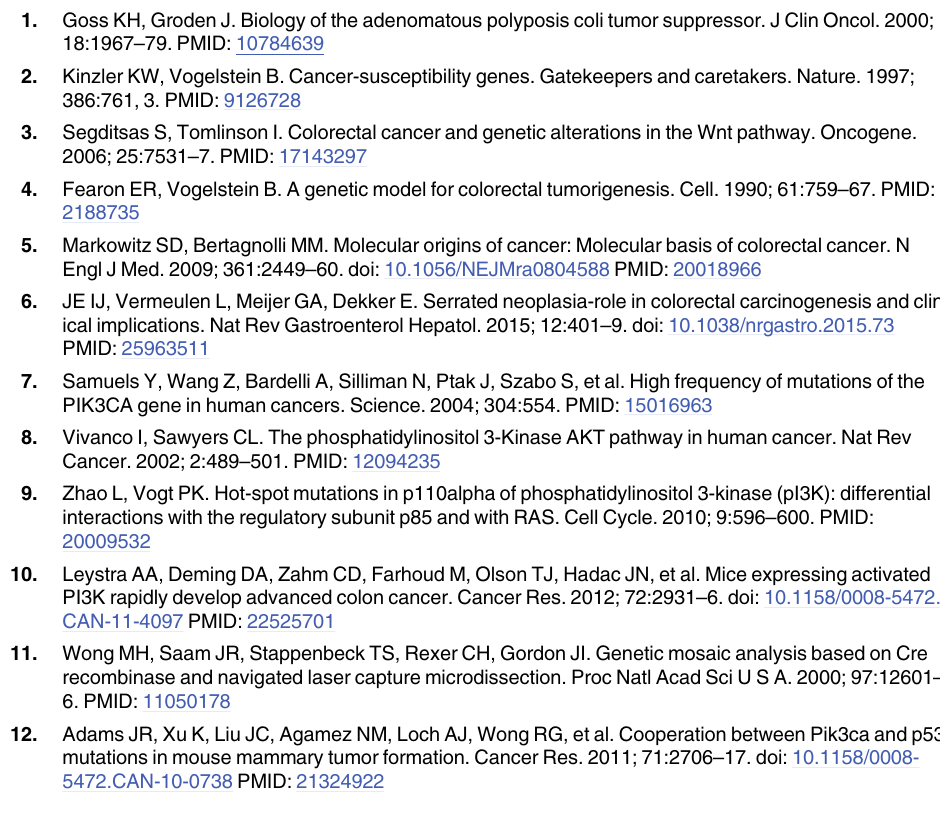
S2 Table. Pretreatment volume of tumors imaged with